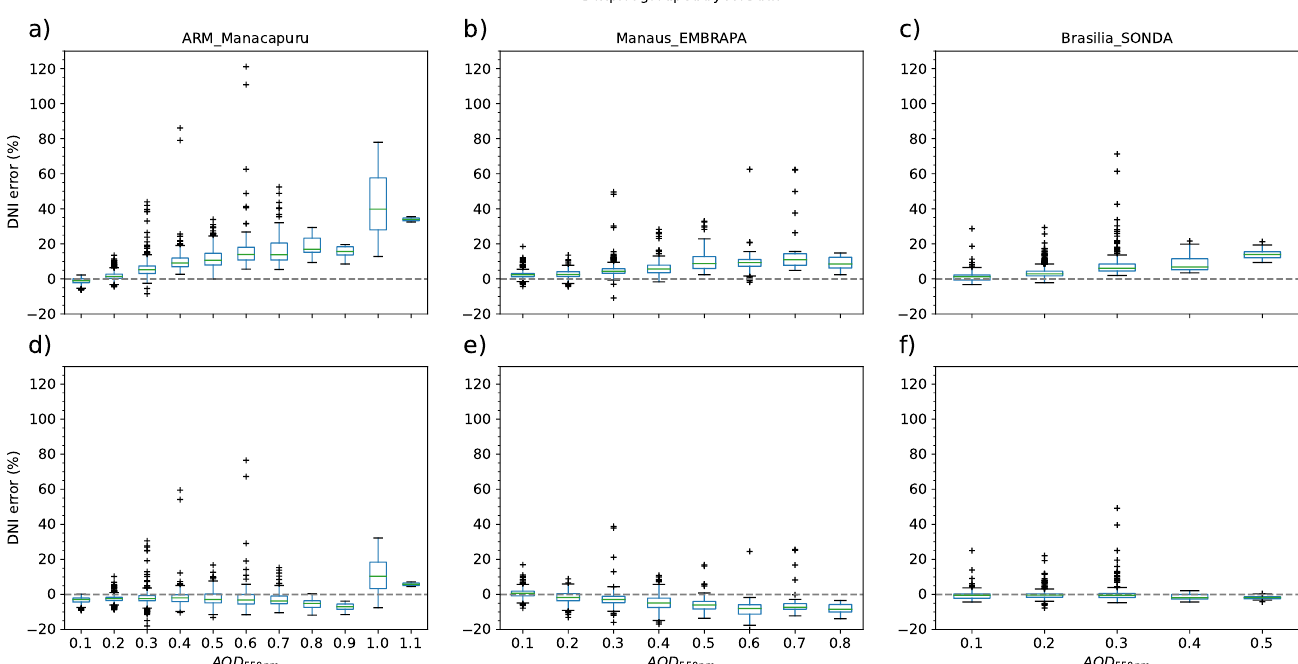
Figure 11. Box-and-whisker plot of the error in DNI between observational data and BRASIL-SR obtained with δ -Eddington scaling ( a – c ) and without scaling ( d – f ) for experiment in-situ . Sites ARM_Manacapuru ( a , d ), Manaus_EMBRAPA ( b , e ) and Brasilia_SONDA ( c , f ). A threshold of SZA ≤ 75 ◦ was